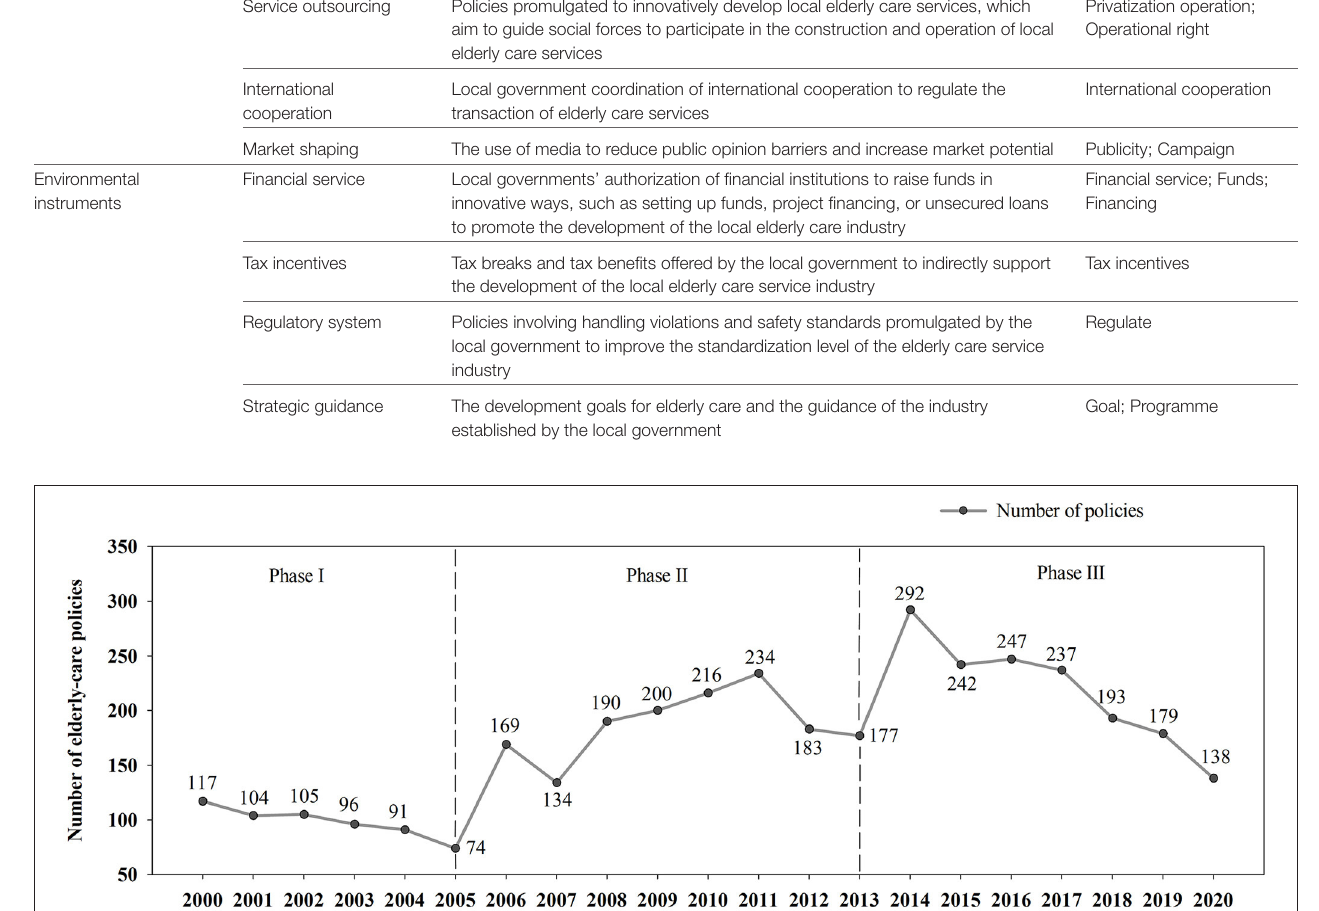
responsibilities of families and communities regarding